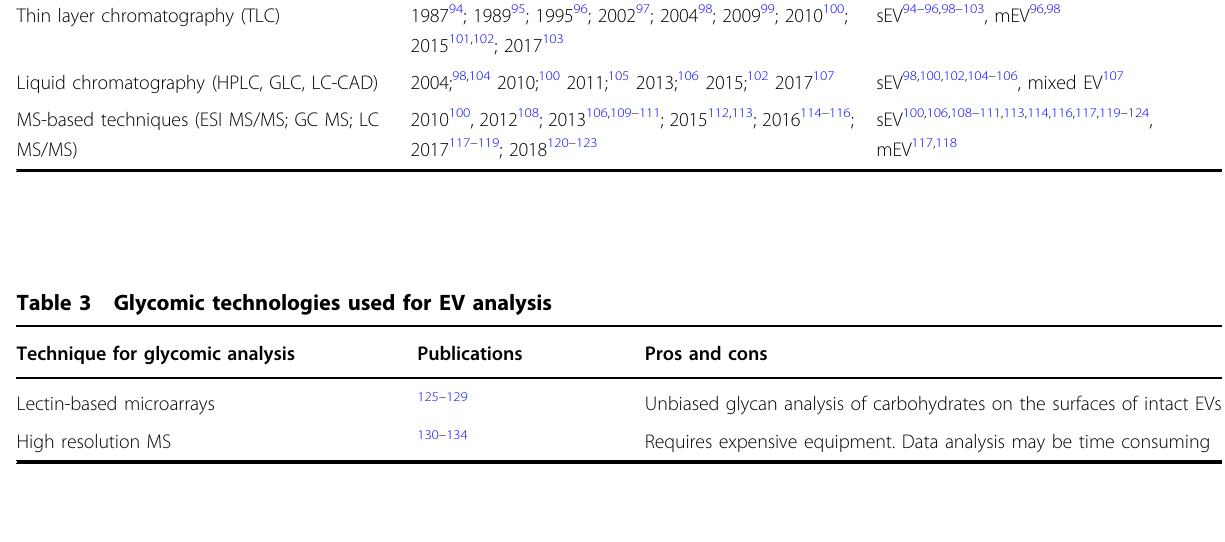
Table 2 Lipidomic analyses of EVs Technique for lipidomic analysis